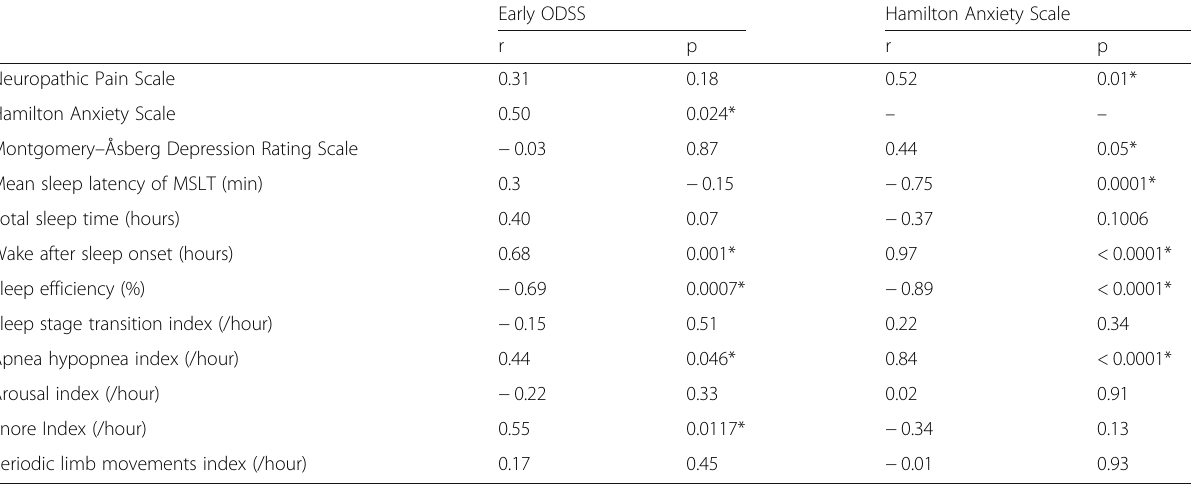
Table 2 Correlations of the Overall Disability Sum Score and Hamilton Anxiety Scale with other studied parameters in Gullian Barré patients at initial assessment